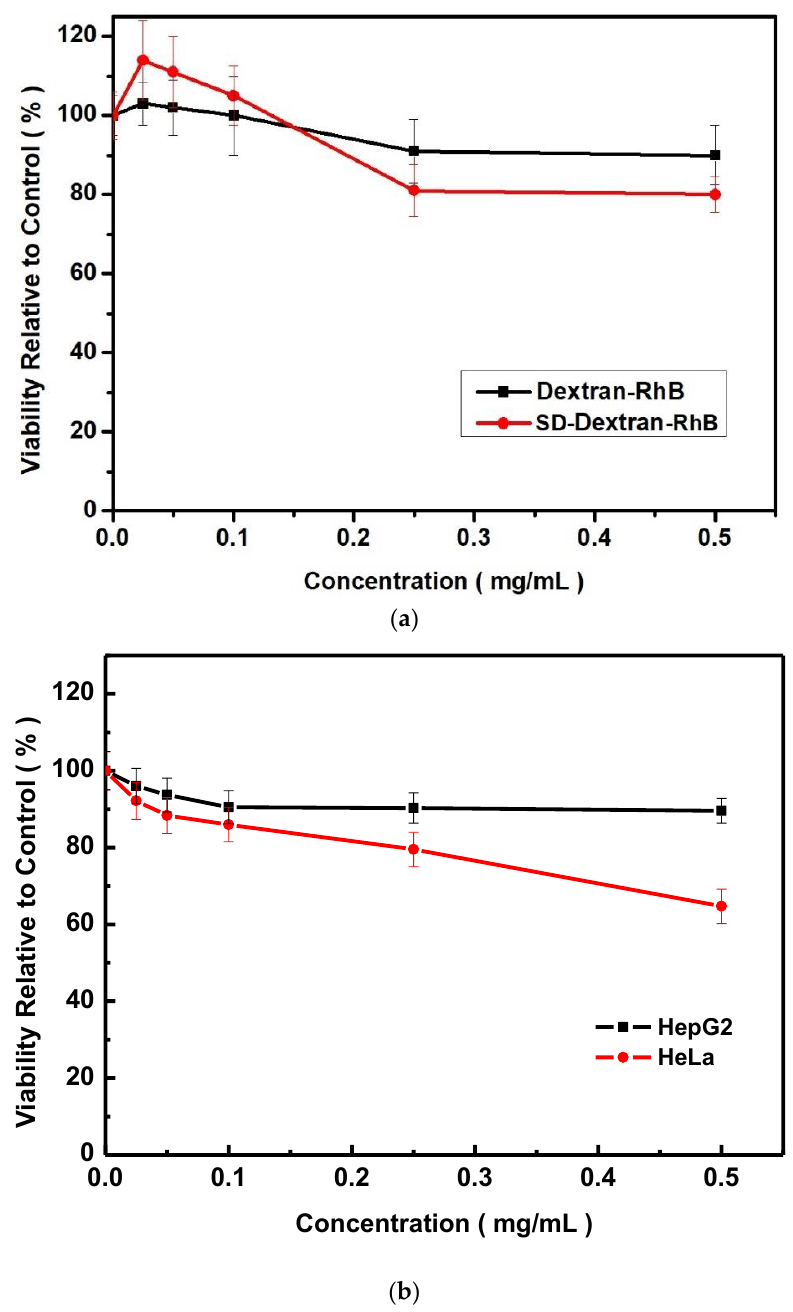
Figure 5. Cell toxicity assay of Dextran-RhB and SD-Dextran-RhB to normal 293 cells ( a ) and SD- Dextran-RhB ( b ) to HepG2 and HeLa cells.